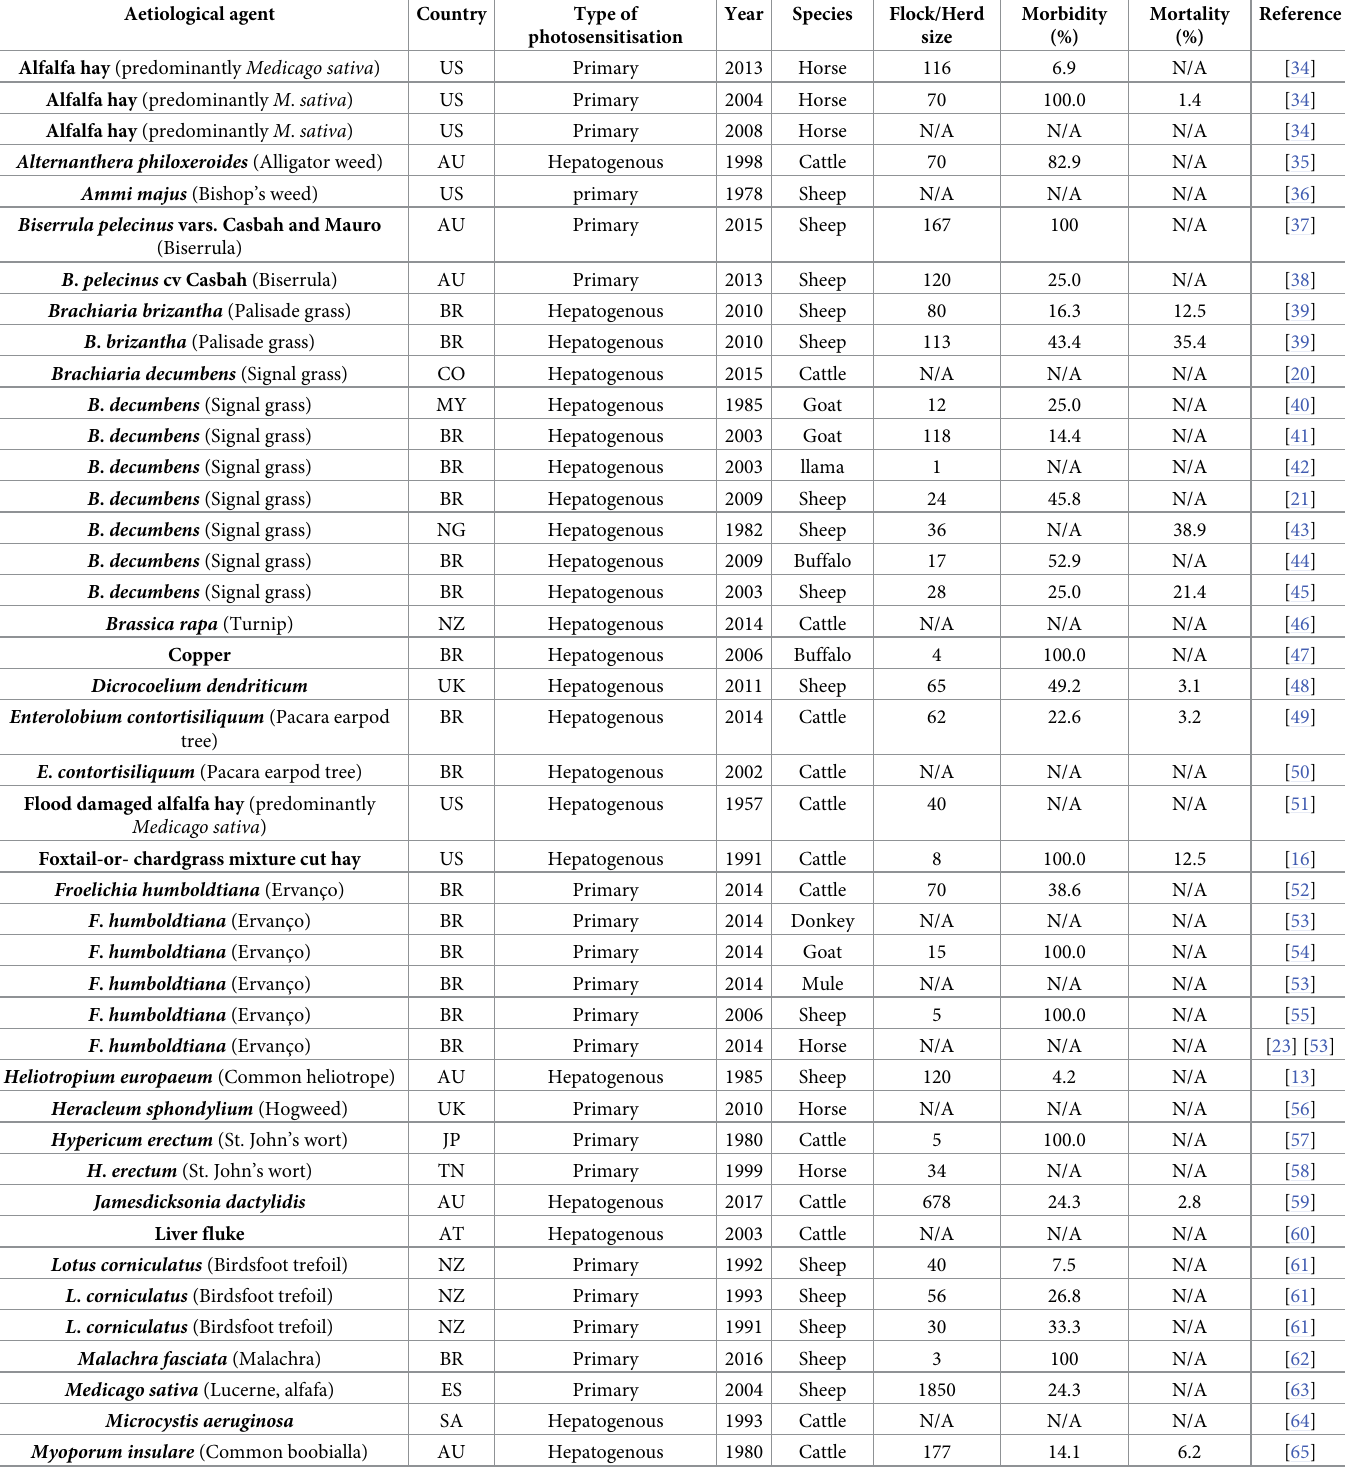
Table 1. Extracted photosensitisation outbreak data from the peer-reviewed literature by aetiological agent. Percentage morbidity and mortality are included where